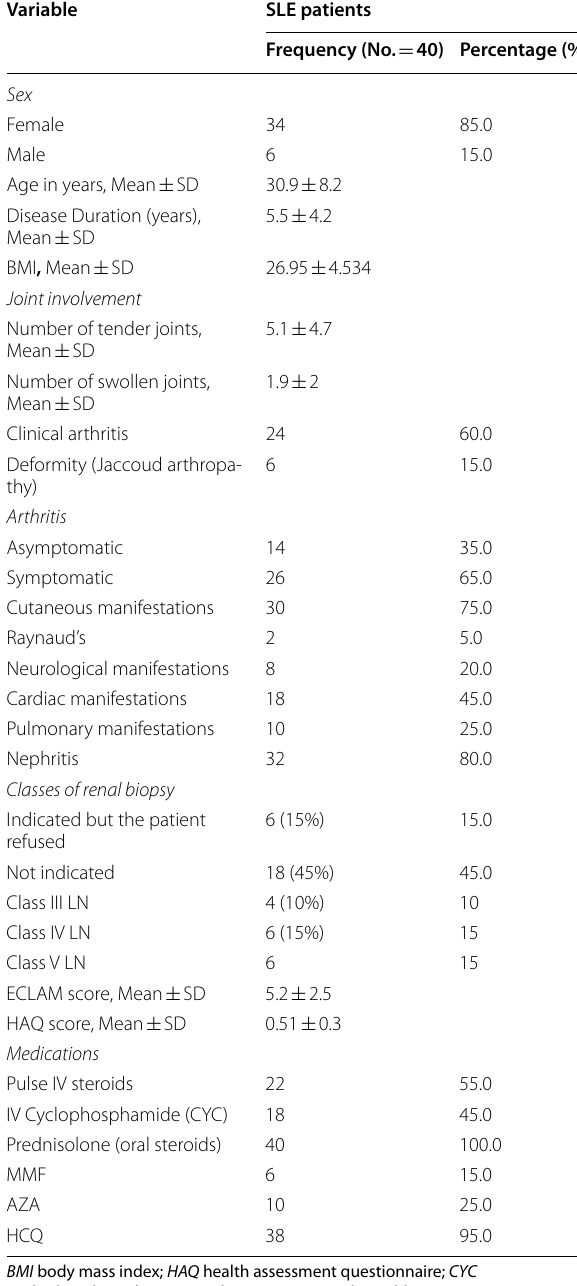
Table 1 Demographic and clinical characteristics of SLE